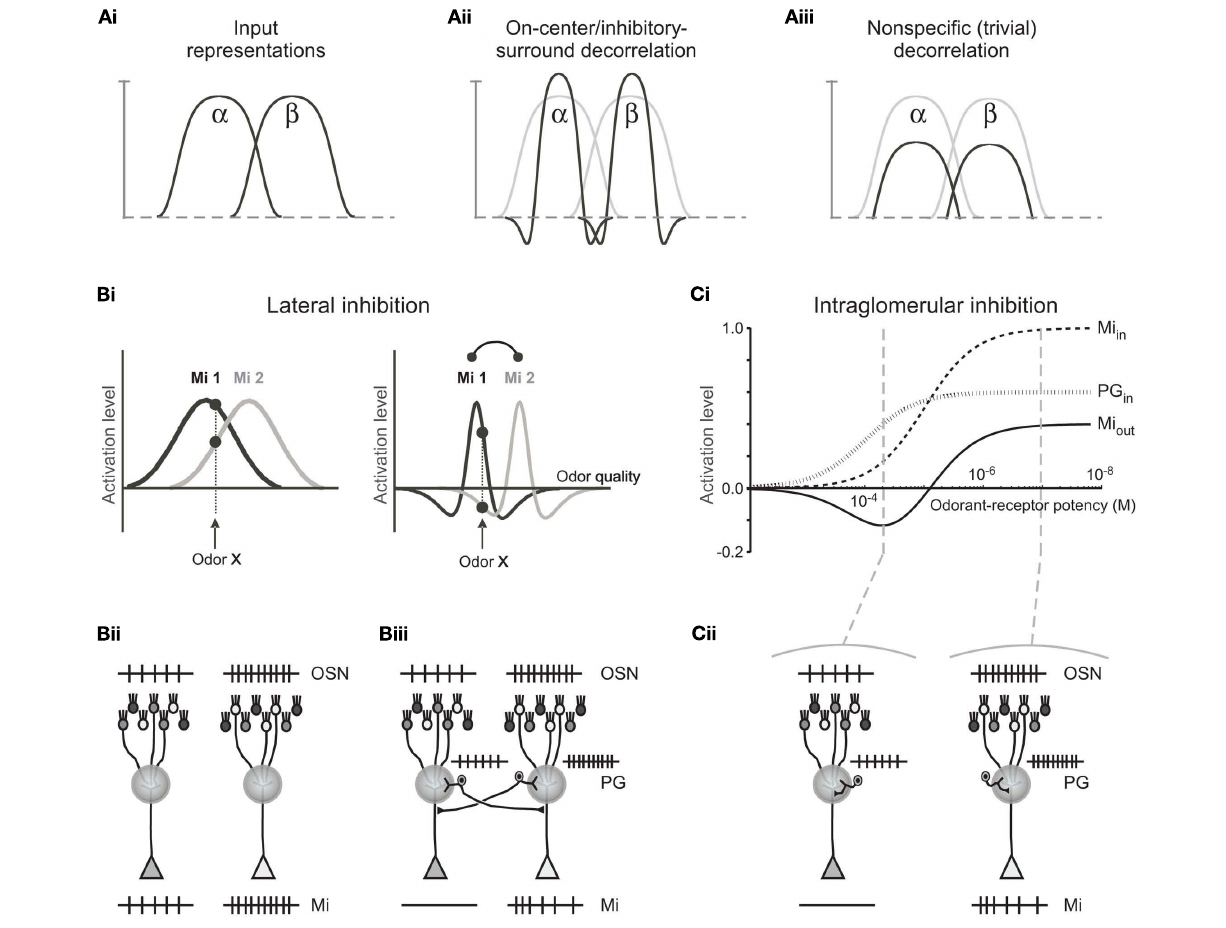
FIGURE 1 | Comparison of decorrelation models. (A) Schematic comparison of on-center/inhibitory surround and non-specific decorrelation functions. (i) Two overlapping input representations ( α and β ) depicted in one dimension. (ii) Canonical on-center/inhibitory-surround decorrelation generates an explicit inhibitory surround in which the shoulders of the input representation are inhibited below baseline, yielding a sharp reduction in overlap among similar representations.This computation is performed by lateral inhibition in the retina and cochlear nucleus, and by the non-topographical model of olfactory receptive field decorrelation. (iii) A lesser degree of decorrelation can be obtained by broad, non-specific inhibition, including lateral inhibition with an unstructured surround, although this imposes a general reduction in sensitivity across the entire representation.This is the effect of most lateral inhibitory models studied to date in the olfactory bulb; notably, it does not generate the inhibitory surround observed byYokoi et al. (1995).Whereas both computations can effect a measurable decorrelation in principle, the two transformations differ both